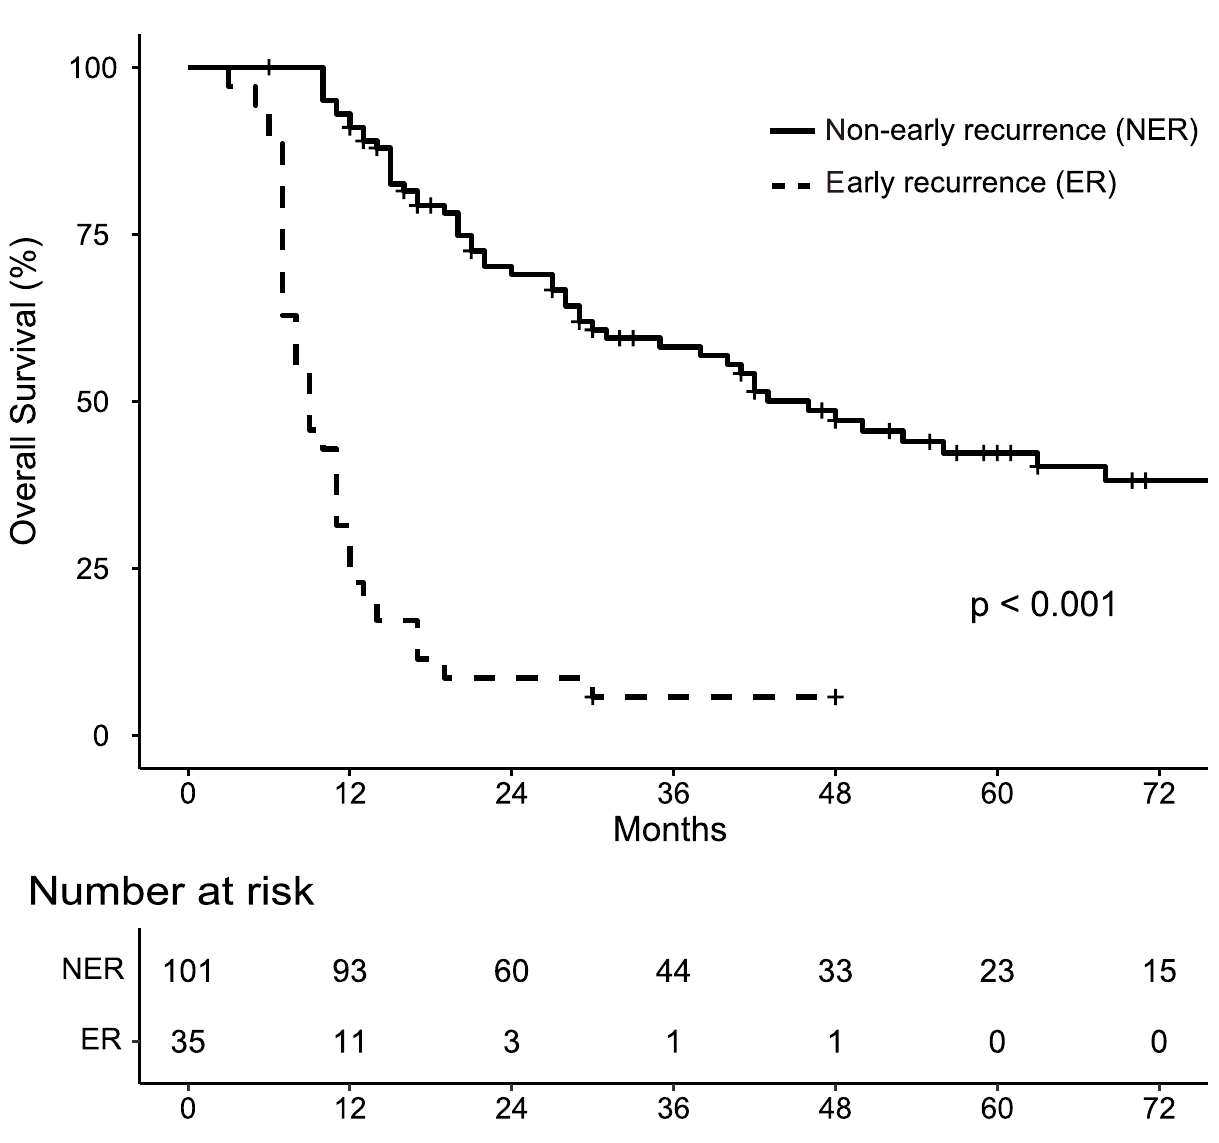
Fig 1. Kaplan-Meier analysis of overall